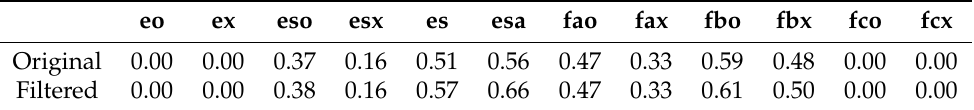
Table 4. Comparison of the IoU between the original and the filtered outputs.